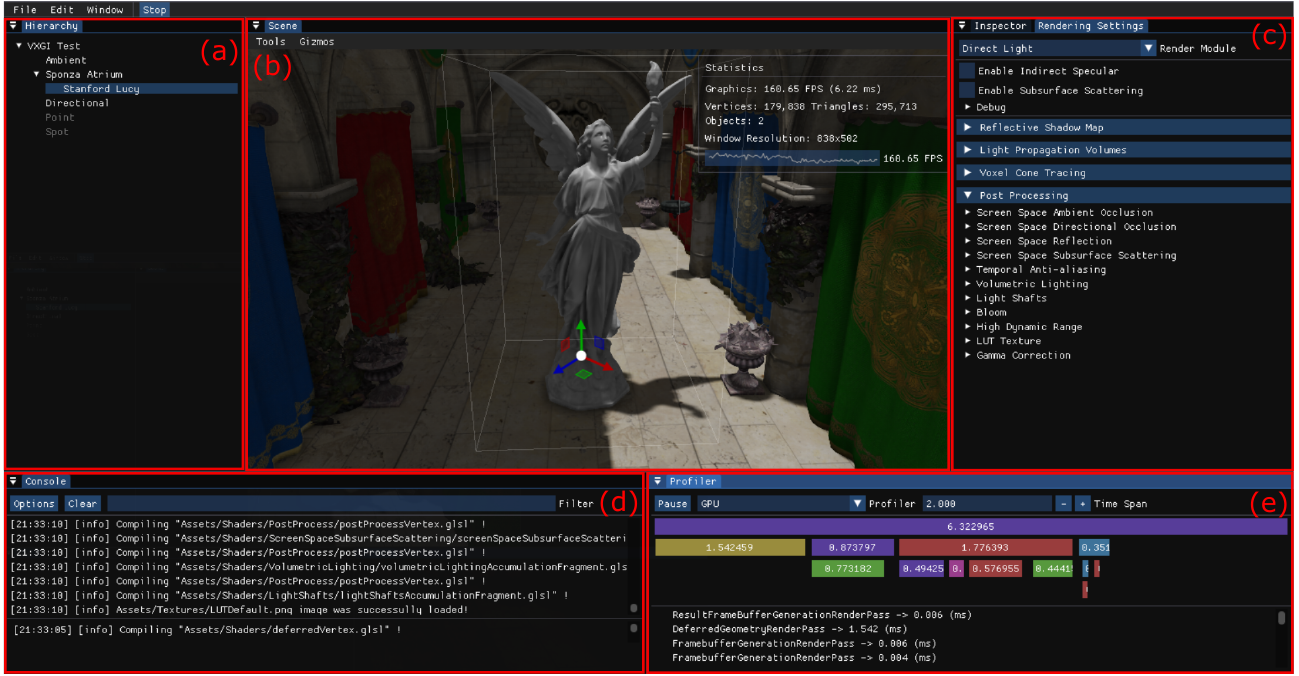
Figure 2. Editor GUI designed for the framework. Panel ( a )—the window that displays the objects hierarchy of the scene; Panel ( b )—the window that displays the result of the rendering pipeline; Panel ( c )—rendering pipeline parameter management window; Panel ( d )—debug information display window; Panel ( e )—CPU and GPU profiler information display